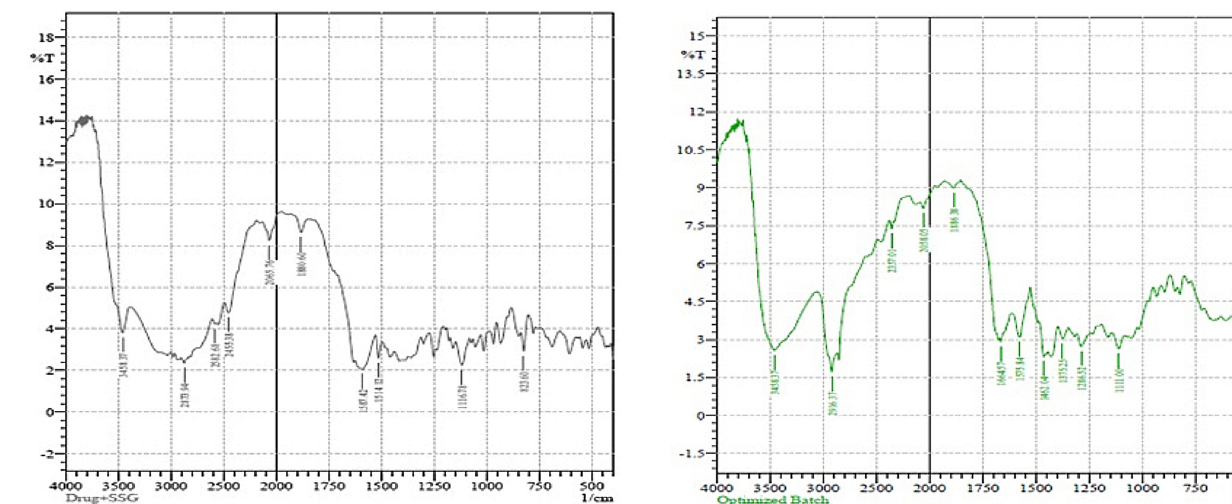
FIGURE 5 - FT-IR spectrum of metoprolol tartrate with optimized FDT